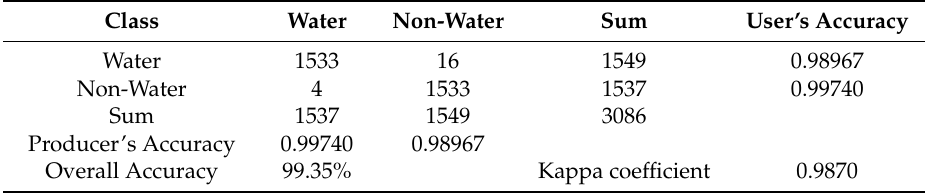
Figure 4. Water body identification results at the test site: ( a ) density slicing; ( b ) NDWI; ( c ) MNDWI; ( d ) ML; ( e ) SVM; and ( f ) JDT. Red boxes show smaller river network ends, whereas the light blue box inside the images shows the area with a complex urban area, smaller water bodies and a lake with bridges. Table 5. Validation statistics of density slicing of the SWIR_1 band for water body identification.